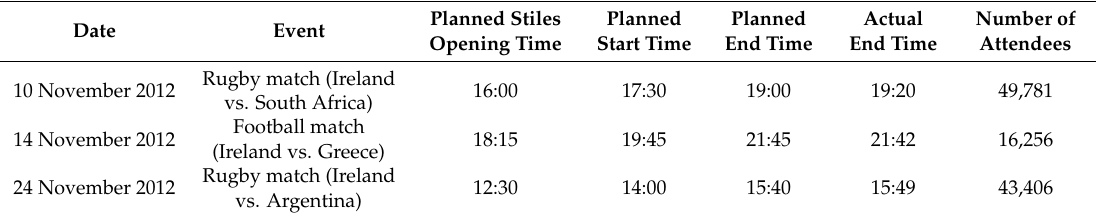
Table 1. Occurrences of big events in the stadium during the study